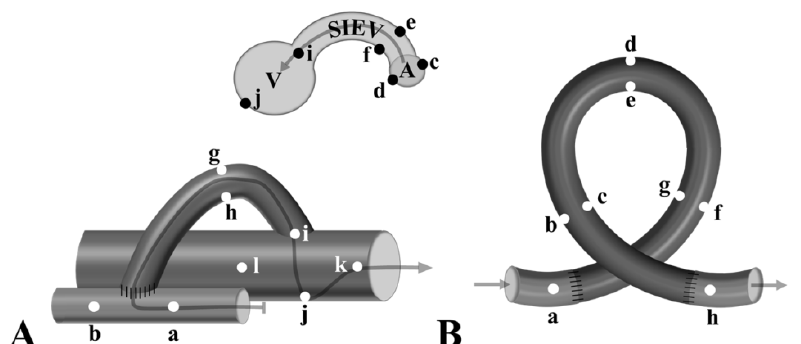
Figure 3. Schematic graphs of the AVF ( A ) and the loop ( B ) models showing the locations of the WSS and pressure measurements from the 3D flow simulation data.